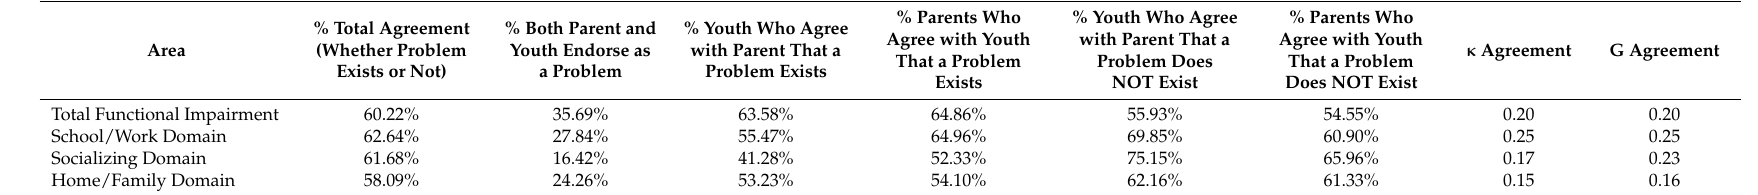
Table 1. Parent and youth agreement on problematic functional impairment total and domains.